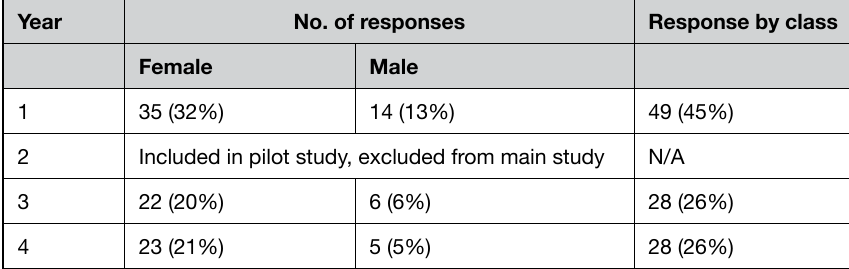
Table 1: Student responses by year of study (N =